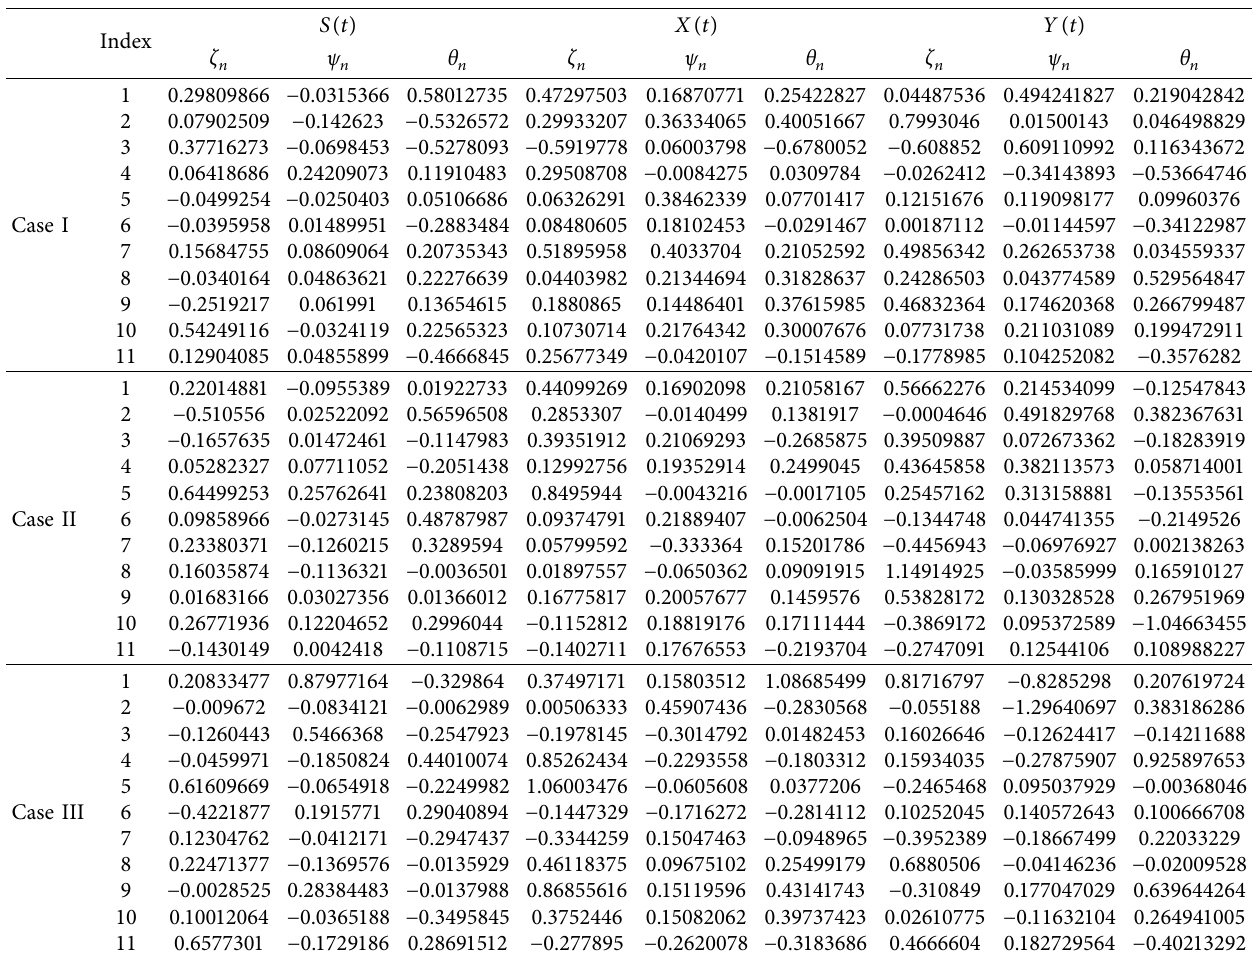
Table 26: Unknown parameters obtained by the LeNN-WOA-NM algorithm for the prey-predator model under the influence of variations in the increasing rate of immigrant prey α 2